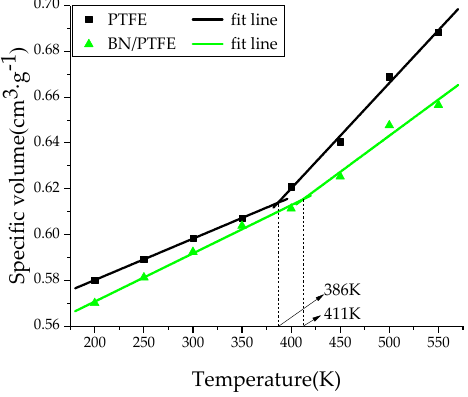
Figure 2. Determination of T g for PTFE and BN/PTFE models.